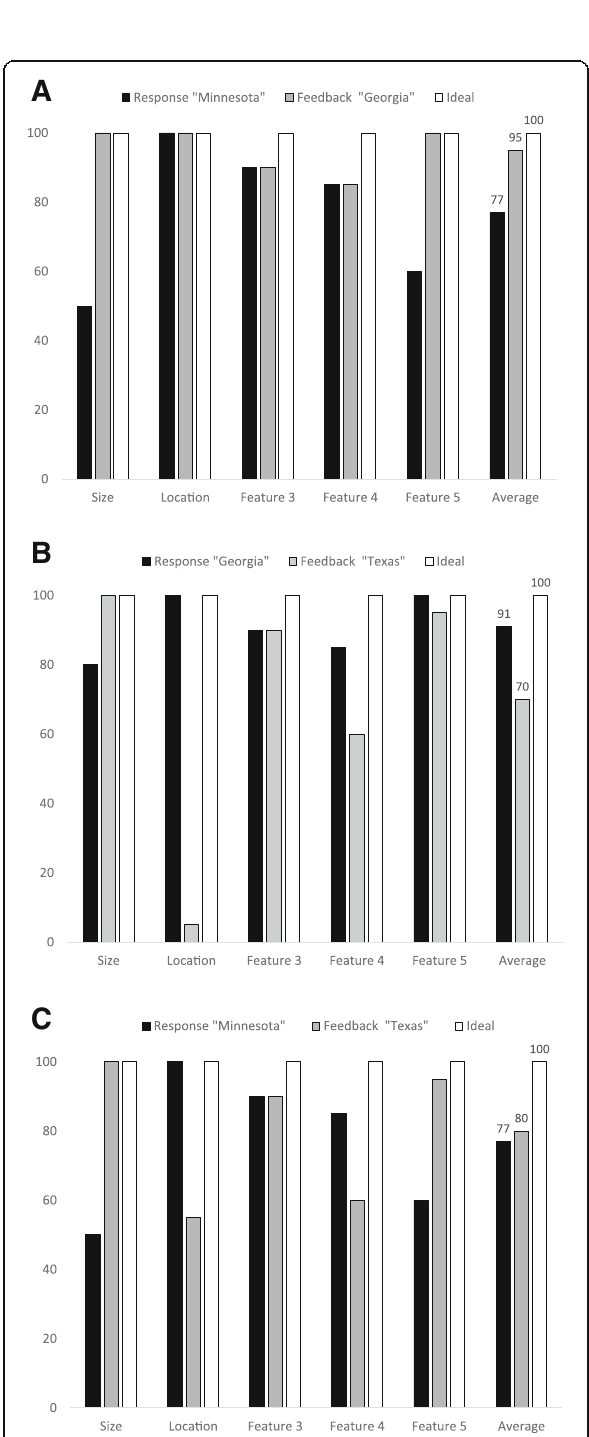
Fig. 5 Hypothetical results from a feature-matching model in which the accuracy of relevant features of the response and feedback are compared to guide a decision about whether to adopt or reject the feedback. a Incorrect response, true feedback. b Correct response, false feedback. c Incorrect response, false